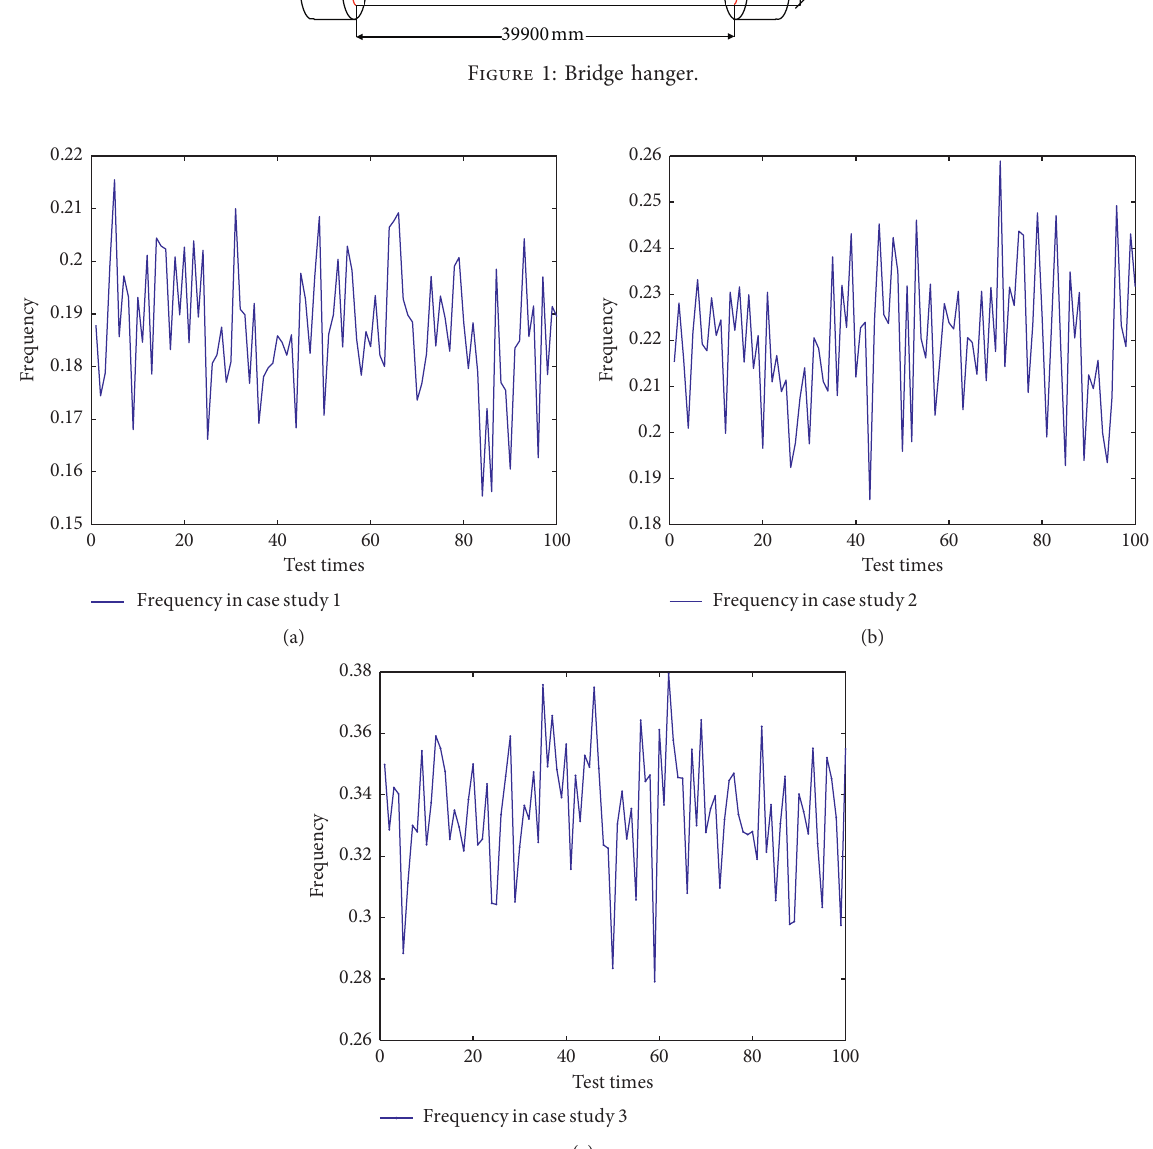
Figure 2: Observed frequency data: (a) case study 1, (b) case study 2, and (c) case study